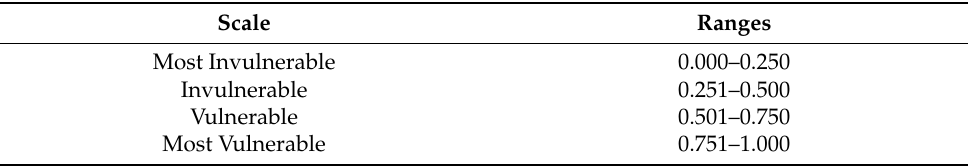
Table 2. Livelihood vulnerability index (LVI)